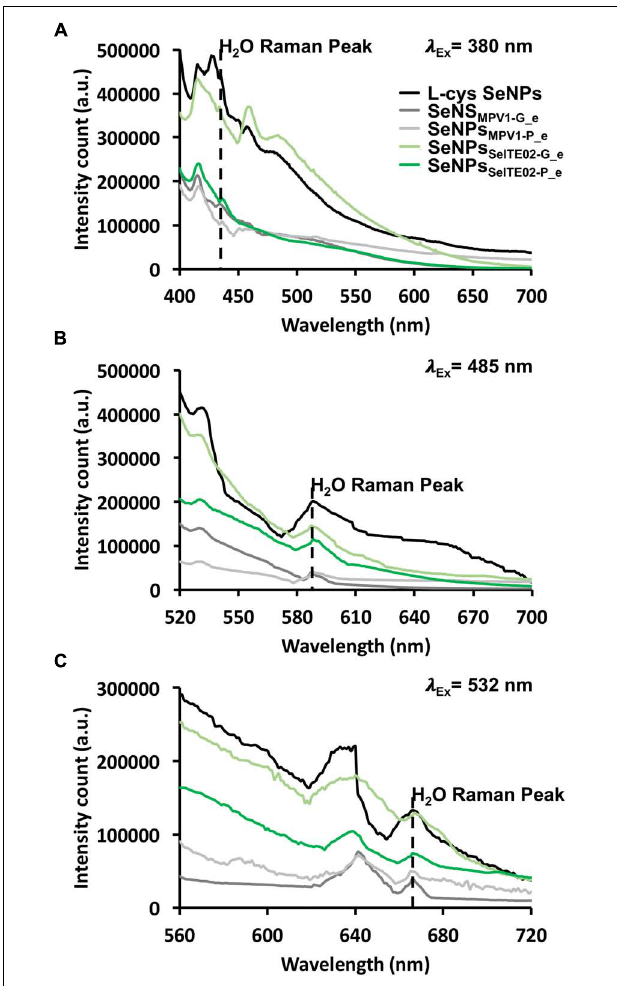
FIGURE 9 | Photoluminescence emission spectra of the unlabeled chemically and biogenically synthesized SeNS at exitation wavelengths of 380 (A) , 485 (B) , and 532 nm (C) . The dashed black line indicates the water Raman